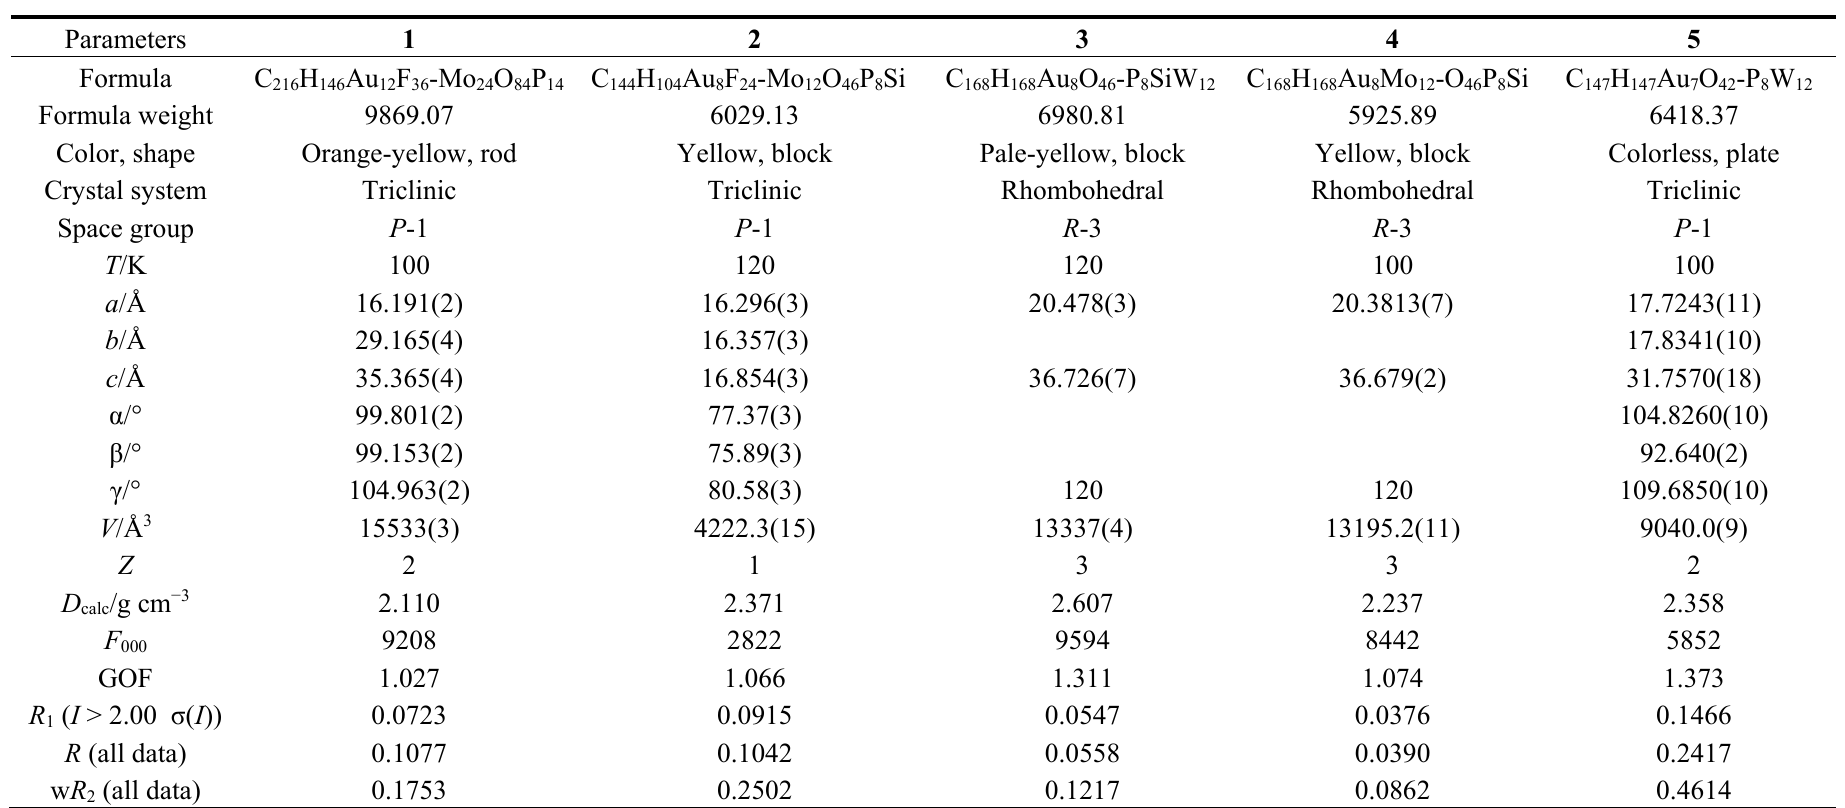
Table 1. Crystallographic data for 1 – 5